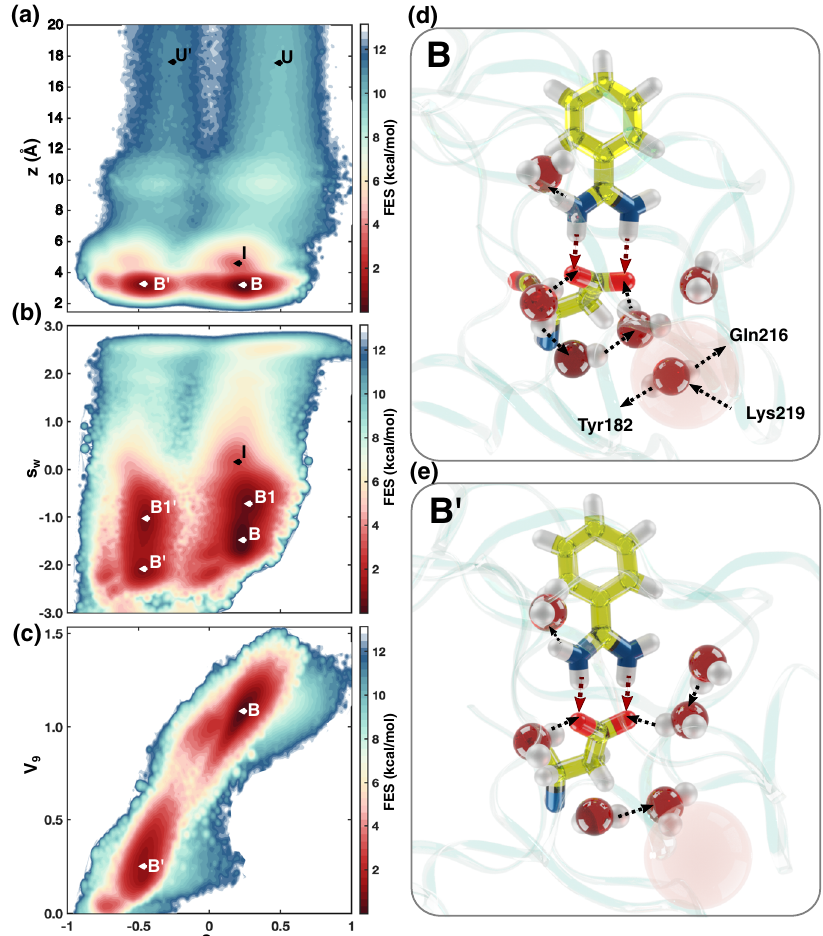
Fig.4|Deep-TICAanalyis. 2DFESalong s t and a z , b s w , c V9.In d and e ,representativecon fi gurationsoftheligandanditssolvationpatterninstatesBandB ’ ,respectively. The location of V9 is highlighted with a semi-transparent pink sphere.